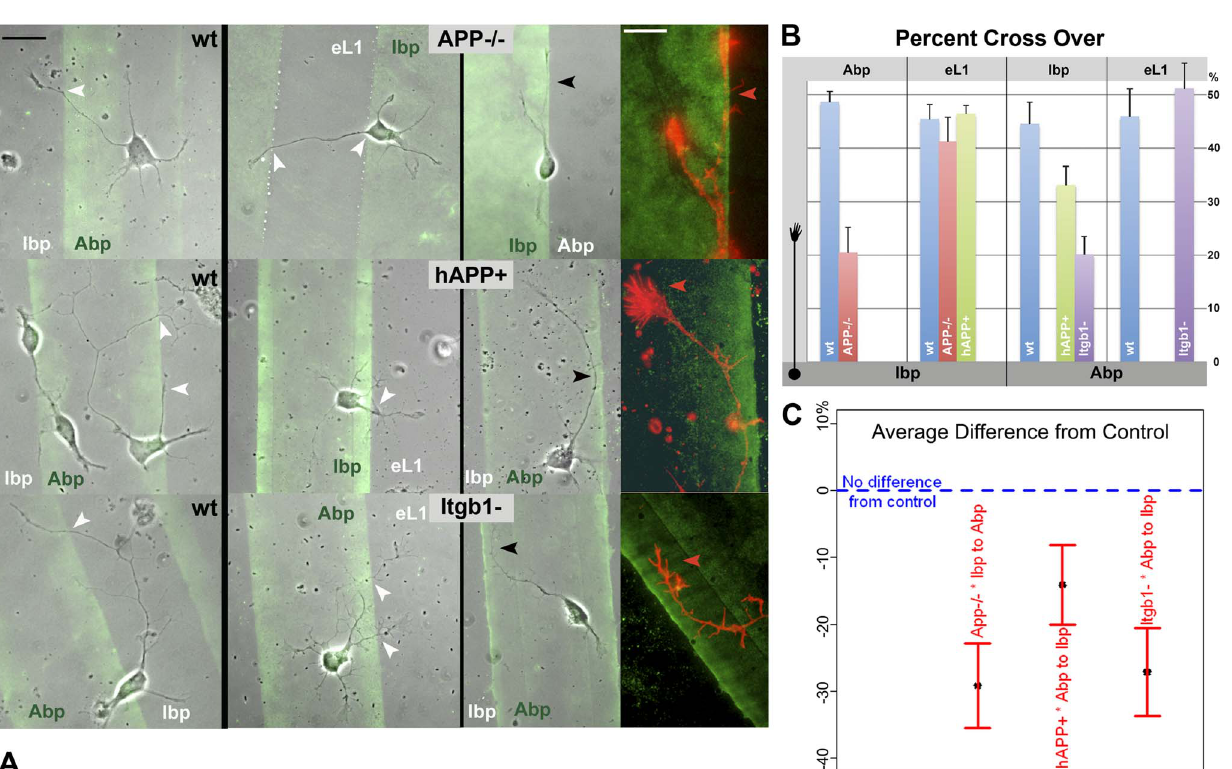
Figure 8. Substrate choice assays of wt versus mutant GCs. Neurons were grown for 24 h on different matrix pairings. The stripe deposited first is green fluorescent. A. Superimposed phase contrast and TIRF images of wt (left column) and mutant neurons (center and right columns). Scale 20 m m. White arrowheads mark neurite crossings from one matrix to another. Axonal GCs with a substrate preference, i.e., avoiding the juxtaposed matrix (black arrowheads), are shown in the right column, together with fluorescence images of phalloidin label (red) of the same structures at